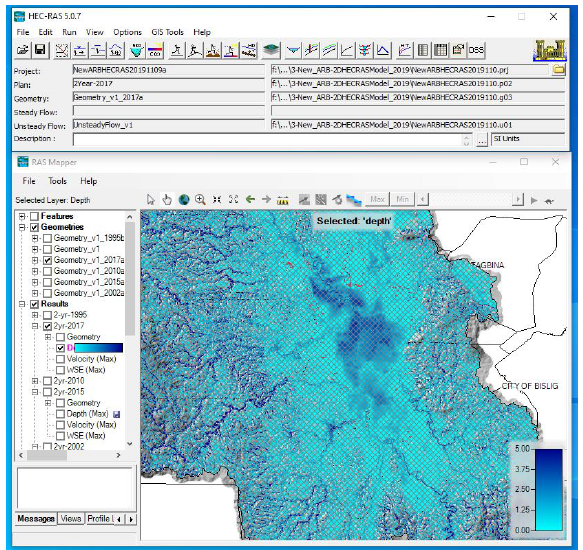
Figure 3. The two-dimensional HEC-RAS model developed for inundation analysis of the Agusan